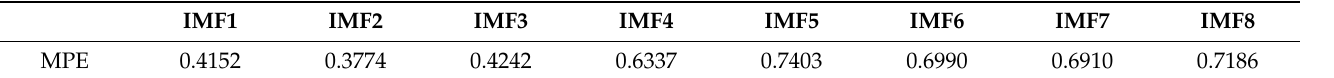
Table 2. Mean value of MPE.